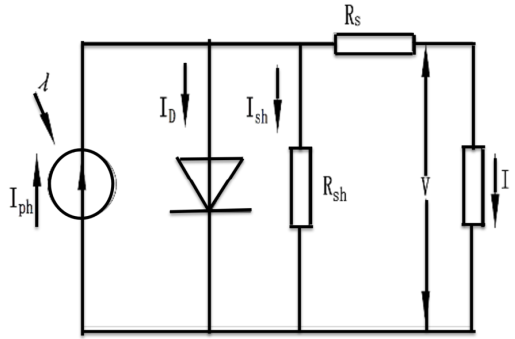
Figure 1. Equivalent circuit of a solar cell.